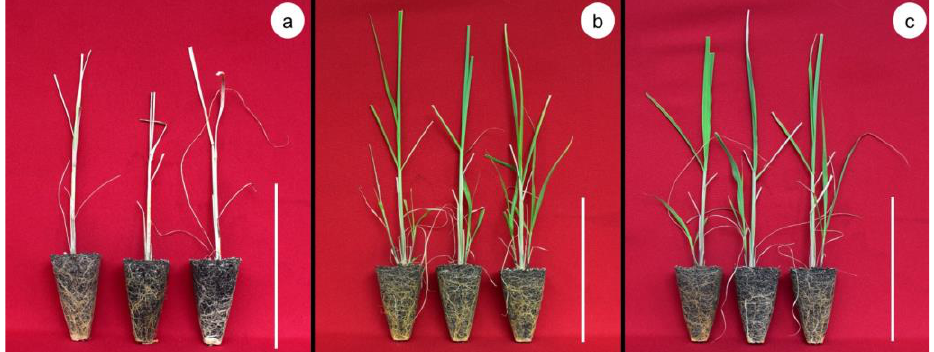
Figure 2. Effect of arbuscular mycorrhizal fungi ( Glomus intraradices ) on survival rate of sugarcane plantlets ( Saccharum spp. cv Mex 69-290) evaluated under drought stress during acclimatization stage. ( a ) Control treatment, ( b ) 100 spores per plantlet, and ( c ) 200 spores per plantlet. White Bar = 30 cm .